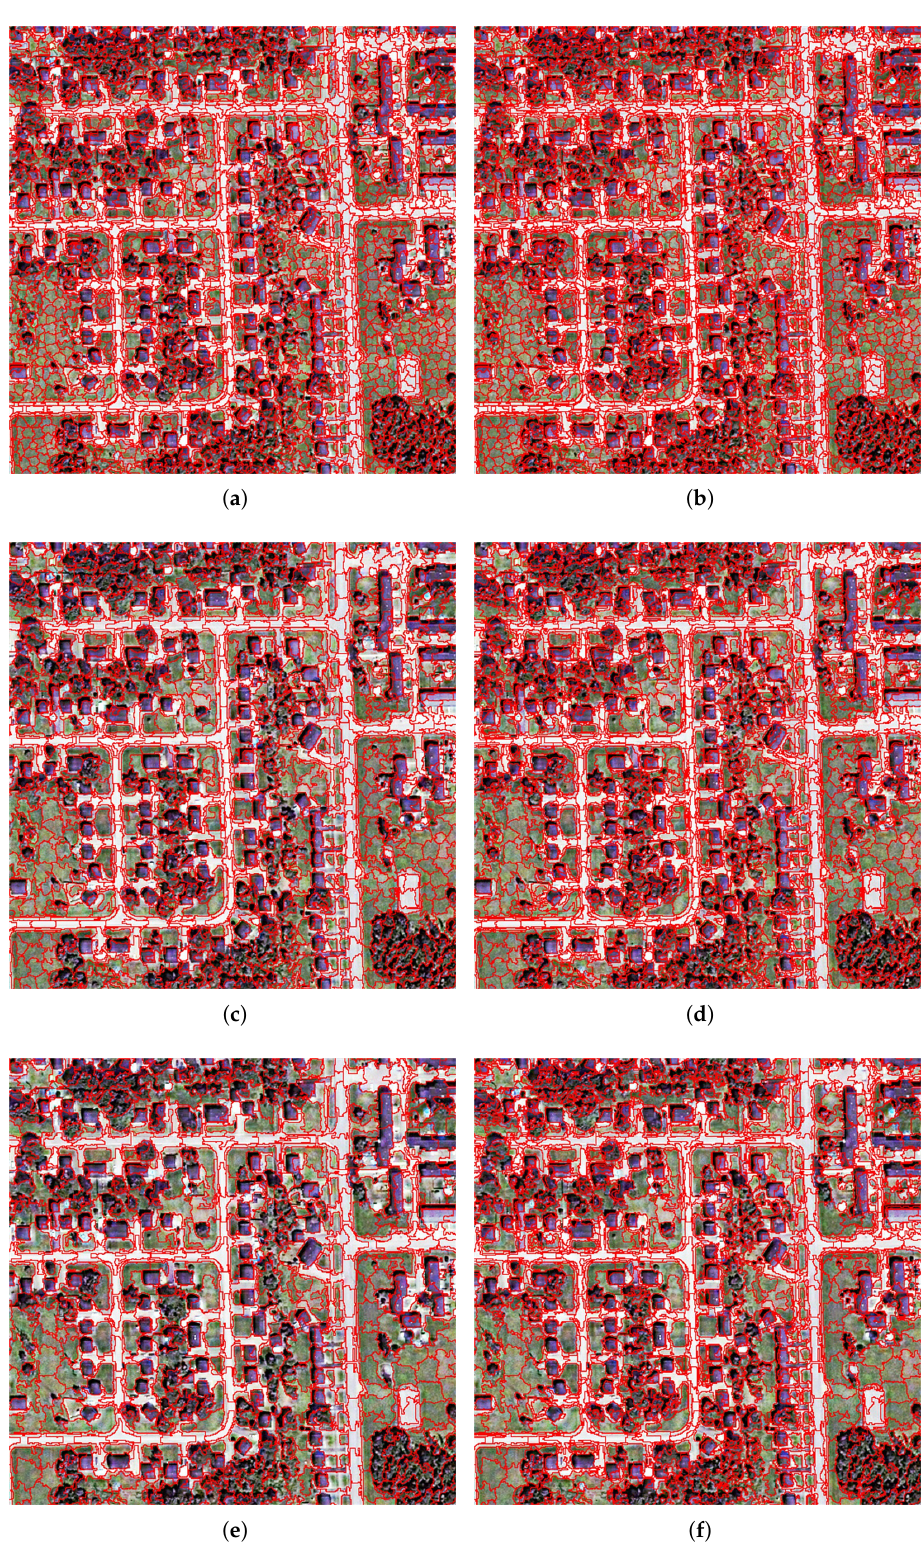
Figure 8. Segmentation maps in three scales: ( a ) 10 × 10 SLIC superpixels; ( b ) 10 × 10 Purified SLIC superpixels; ( c ) 15 × 15 SLIC superpixels; ( d ) 15 × 15 Purified SLIC superpixels; ( e ) 20 × 20 SLIC superpixels; and ( f ) 20 × 20 Purified SLIC